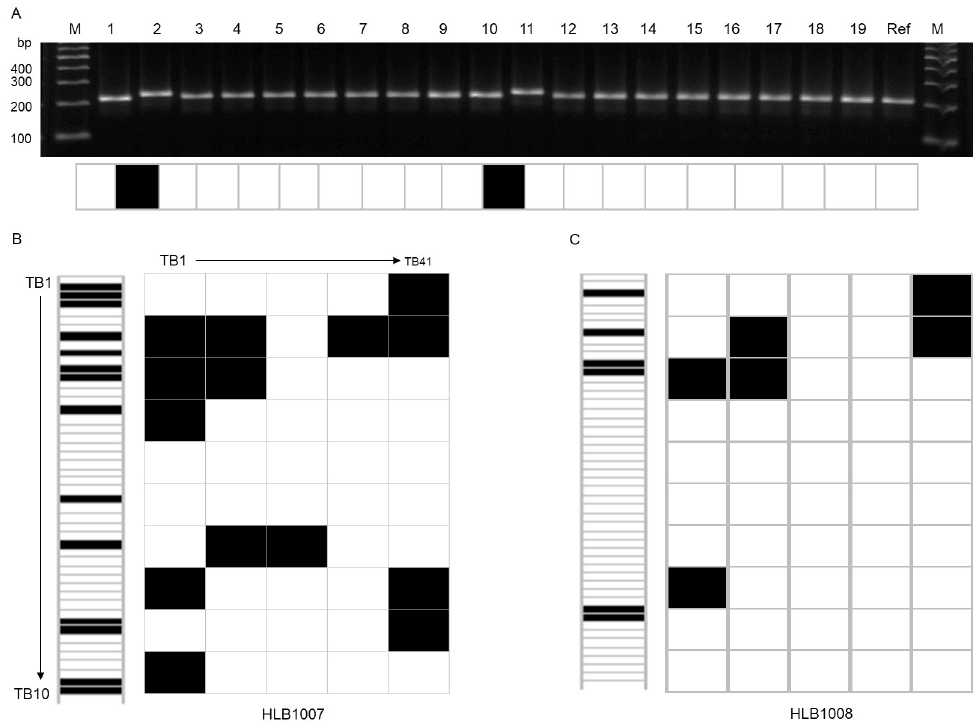
Fig 5. Application of tartary barcode system to tartary accession, HLB1007 and HLB1008. (A) Amplification products and barcode representation of the polymorphisms using InDel marker TB11 on tartary buckwheat accessions. PCR results using the 50 InDels in (B) HLB1007 and (C) HLB1008 were converted to standard 1D and widely-used 2D barcode types in comparison with those in “Daegwan 3–7.” Identical results to the reference genome were represented by white, while other results were represented by black.